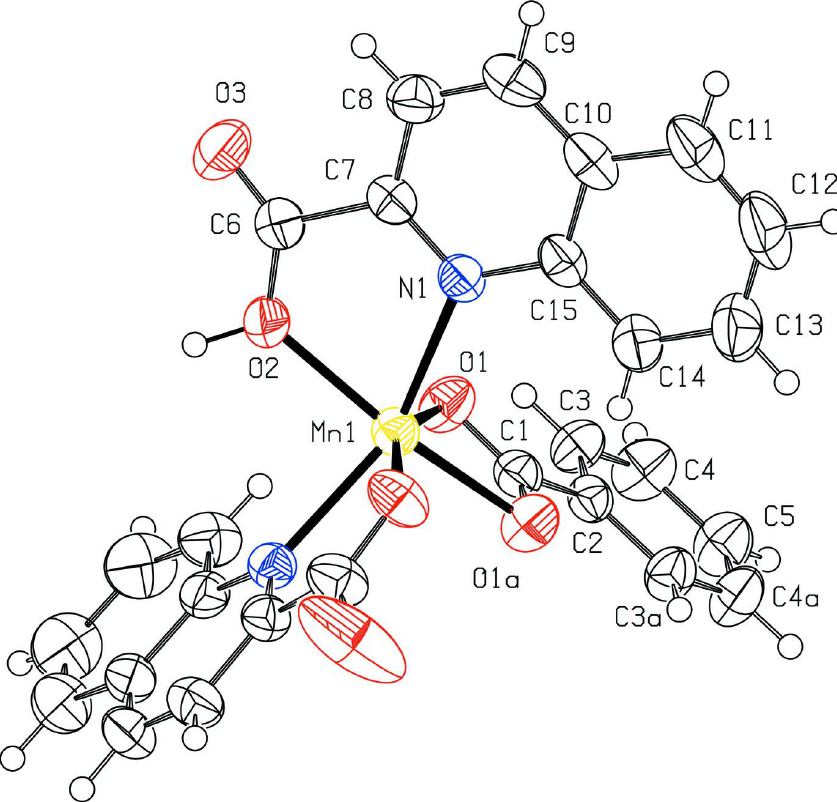
Figure 1 ORTEPII (Johnson, 1976) plot of the title compound. Displacement ellipsoids are drawn at the 50%